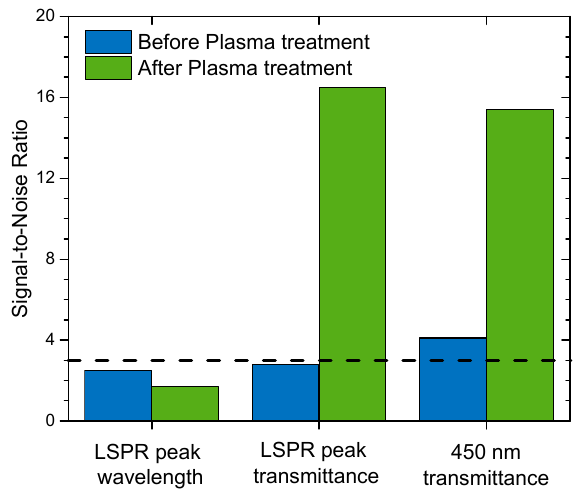
Figure 6. Signal-to-noise ratio (SNR) of the several measured signals, before and after Ar plasma treatment. The dashed line sets the threshold of the minimum SNR needed for detection.